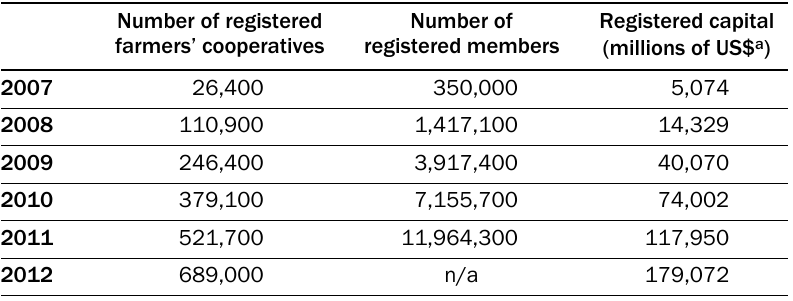
Table 1. Farmers’ Cooperatives Registered at the Bureaus of Industry and Commerce in China,